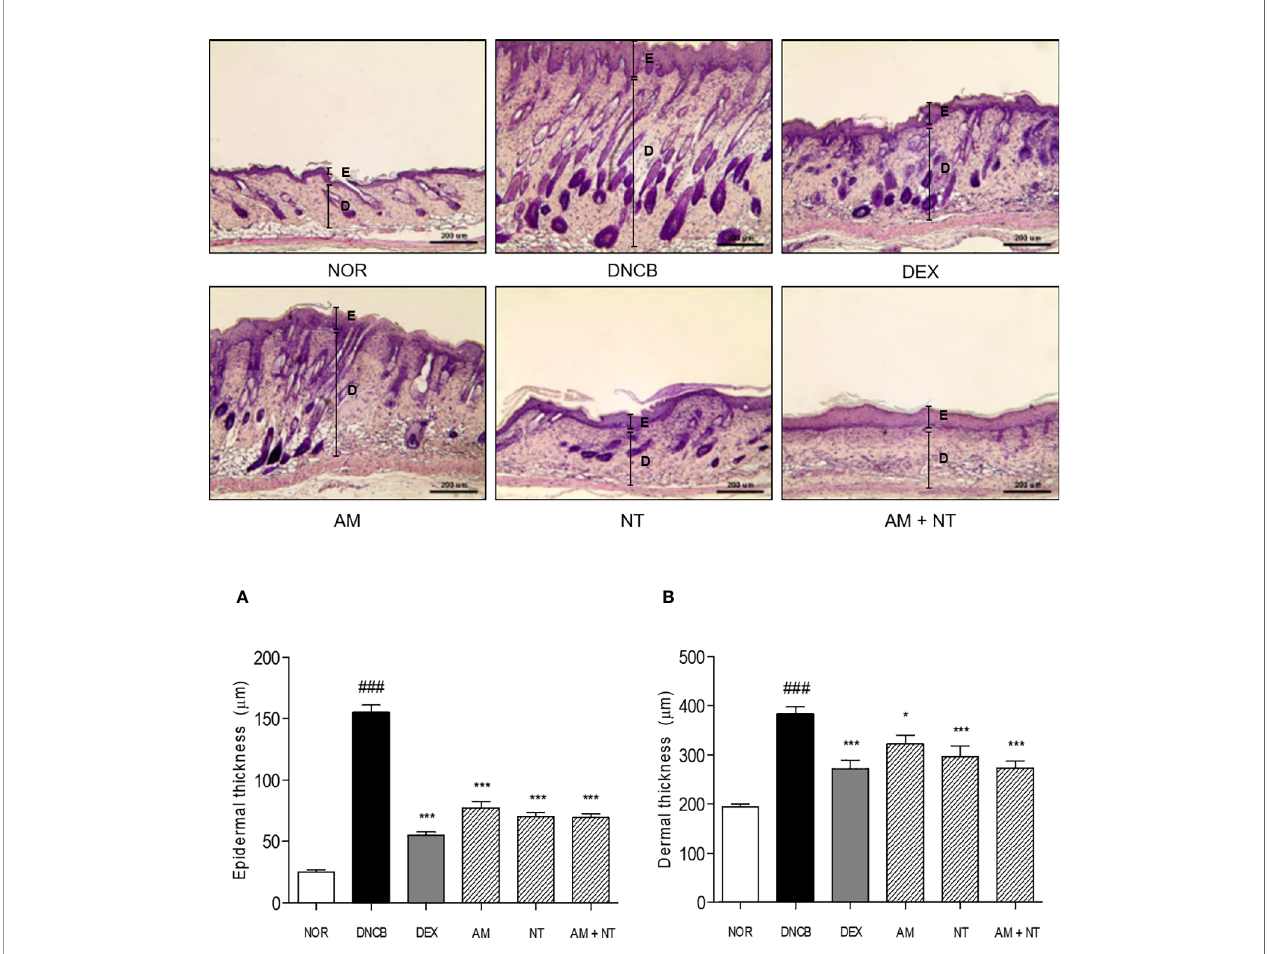
FIGURE 2 | Effects of AM, NT, and a mixture of AM and NT on histopathological features with allergic contact dermatitis skin lesions. Epidermis (A) and dermis (B) thickness were stained with hematoxylin and eosin and measured microscopically. The magni fi cation was ×100. Data were presented as means ± S.E.M (n = 5). ### p < 0.001 vs. NOR; * p < 0.05 and *** p < 0.001 vs. DNCB. Black lines indicate the layer of epidermis (E) and dermis